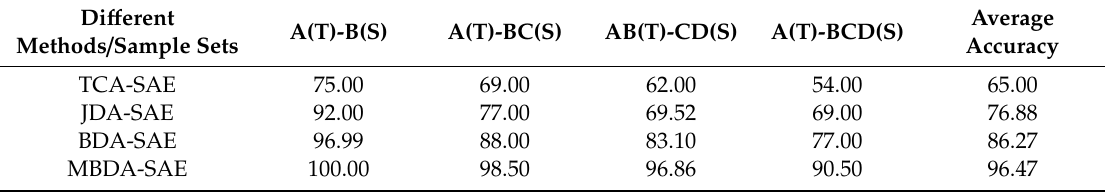
Table 3. Bearing state recognition accuracy under di ff erent methods